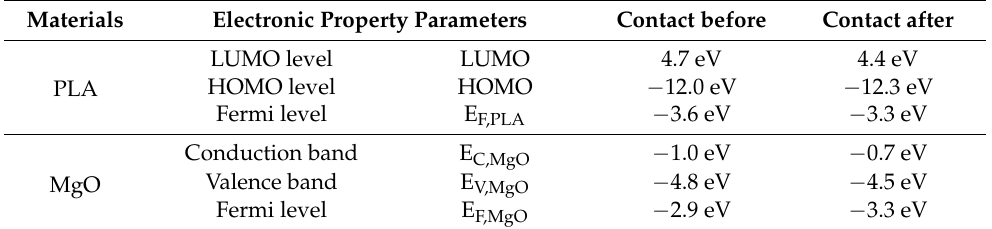
Table 2. Electronic property parameters for PLA and MgO calculated by quantum chemical calculation. Materials Electronic Property Parameters Contact before Contact after LUMO level LUMO PLA Conduction MgO